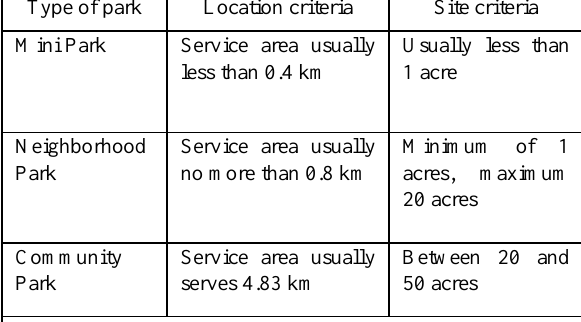
Table 1. Public park and open space classification scheme (Mertes et al, 1995) Note: With a little change proportional to the study